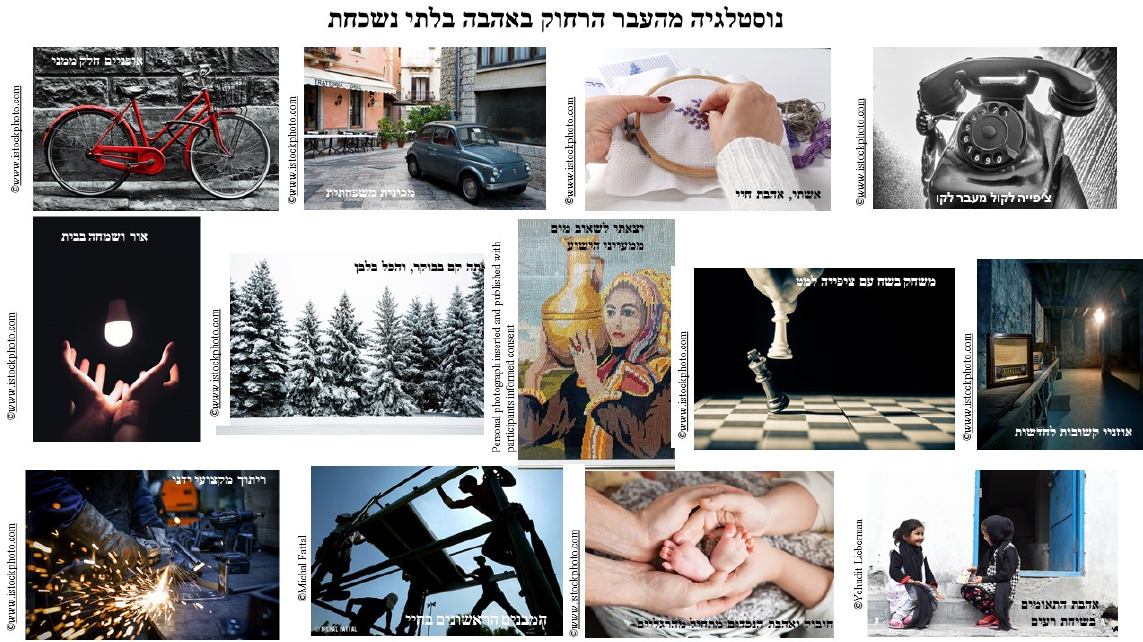
Figure 2. Itzhaks’ third collage titled: “Nostalgia from the far past with unforgettable love” . Reproduced with permission from Michal Fattal, Yehudit Liberman and www.istockphoto.com (accessed on 20 June 2021; 29 June 2021; 3 October 2021).